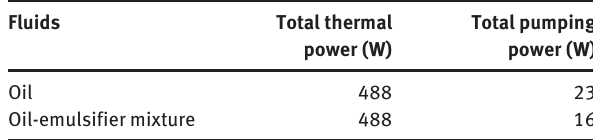
Table 3 Power consumption in the µHX for the two